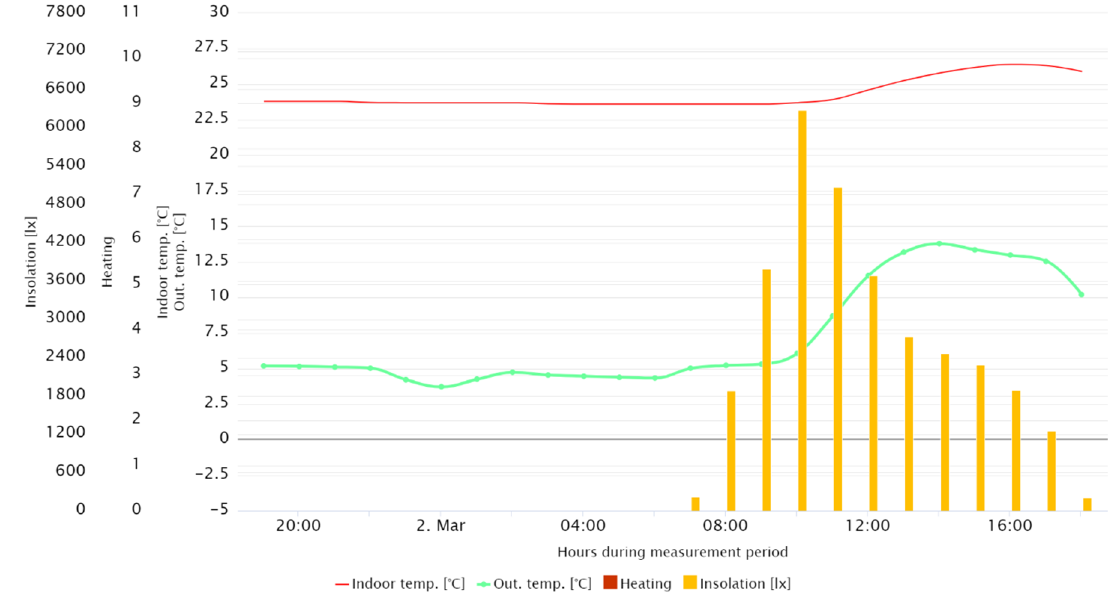
Figure 13. Twenty-four-hour period hourly averages of internal temperature for room 104 referring to heating valve position, insolation, and outdoor temperature.